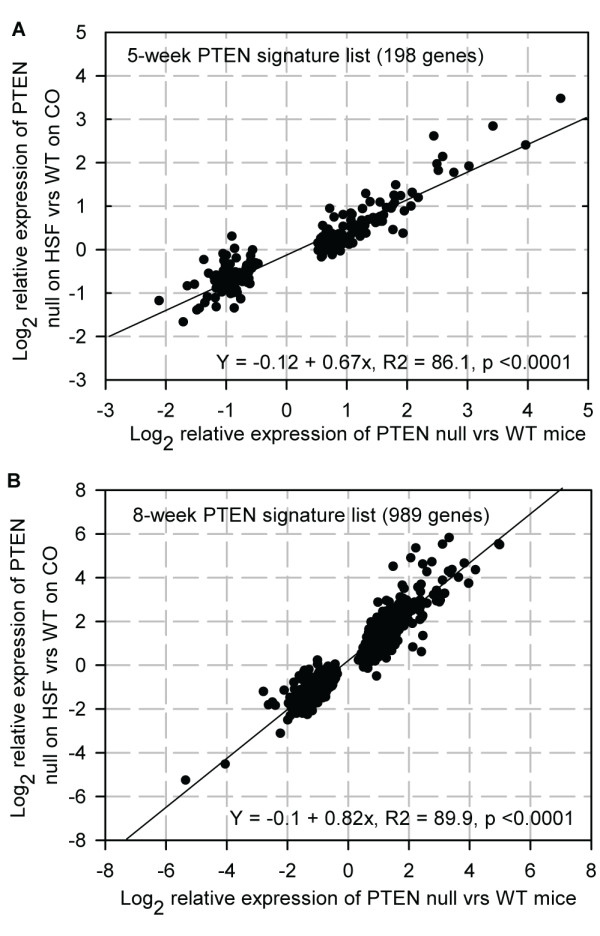
Effect of HSF on the expression of the PTEN null signature genes. A, Expression of the five week 198 PTEN signature list in PTEN null mice fed the control diet compared to WT mice fed control diet, and 5-week old PTEN null mice supplemented with HSF diet compared to WT mice fed control diet. The addition of SF results in the magnitude of change in expression of each gene being suppressed by on average 33% (see Table 1 and Additional file 1 - Table S1). B, Expression of the eight week 989 PTEN signature list in PTEN null mice fed control diet compared to WT mice fed control diet, and 8-week old PTEN null mice supplemented with HSF diet compared to WT mice fed control diet (see Table 1).The addition of SF results in the magnitude of change in expression of each gene being suppressed by on average 18%.